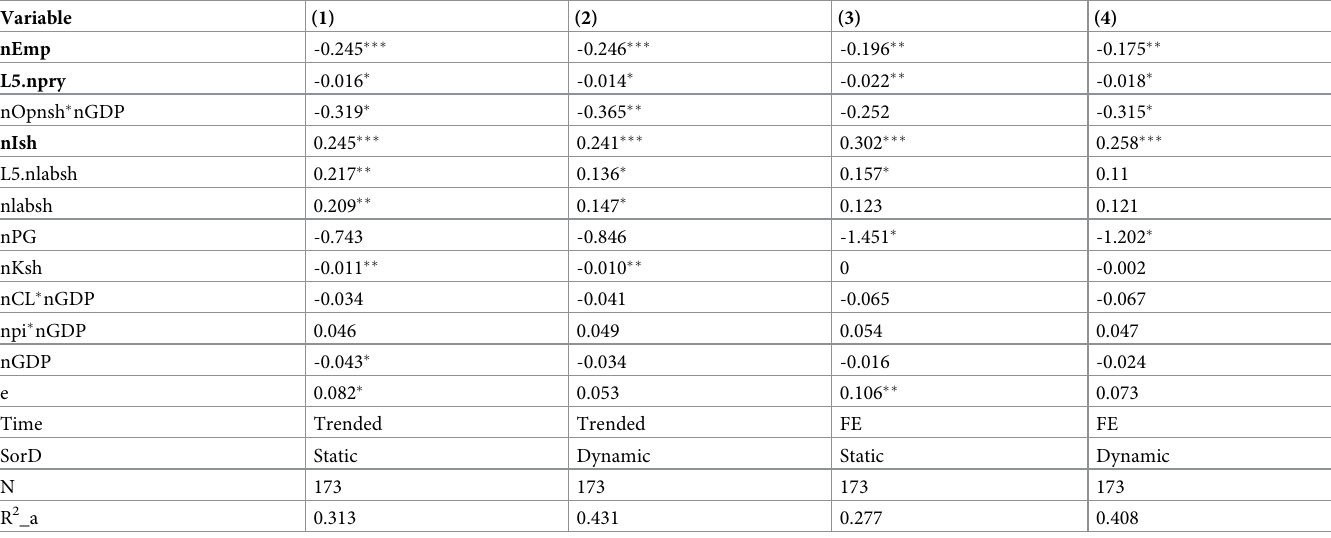
Table 14. Regression results of nGini by